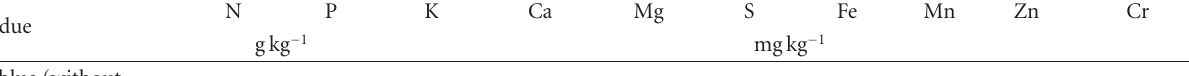
Table 1: Mineral analysis of leather waste before (wet blue) and after the chromium extraction (collagen) ∗ . N P K Ca Mg S Fe Mn Zn Cr Residue gkg − 1 mgkg − 1 wet blue (without chromium extraction)